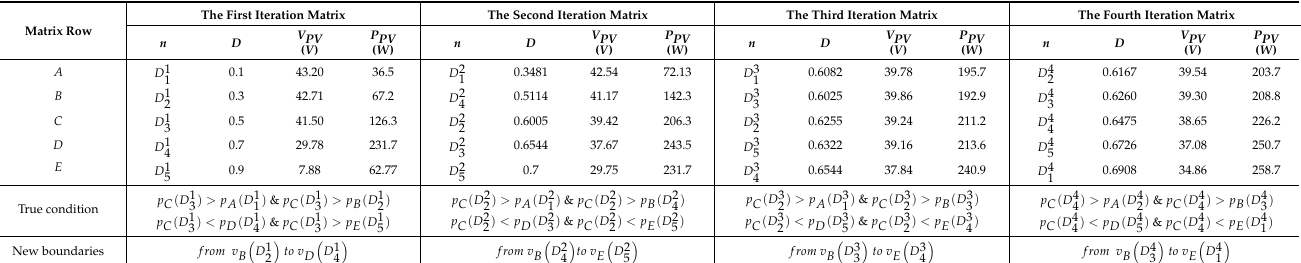
Figure 8. The MPP tracking method for pattern-1. ( a ) The samples’ operating points at the first four iterations. ( b ) The tracking performance by using CSA. ( c ) The tracking performance by using ICSA. Table 5. The rearranged and saved data for pattern-1.